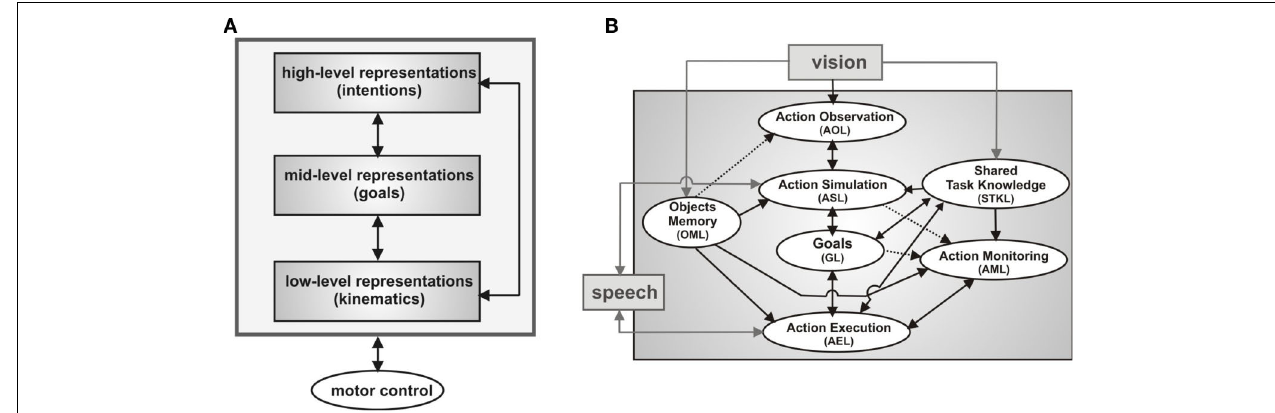
inferred action goal of the partner (layer GL), detected errors (layer AML), contextual cues (layer OML) and shared task knowledge (layer STKL). The goal inference capacity is based on motor simulation (layer